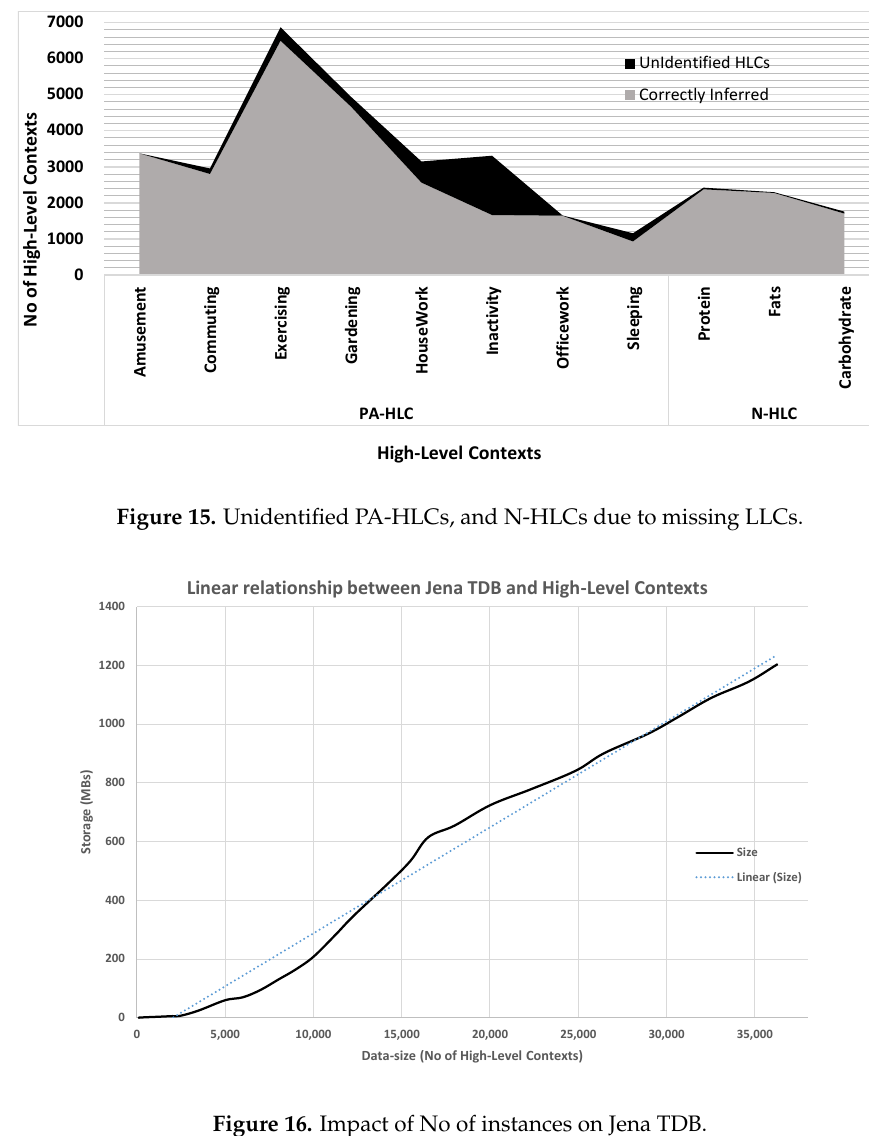
Figure 16. Impact of No of instances on Jena